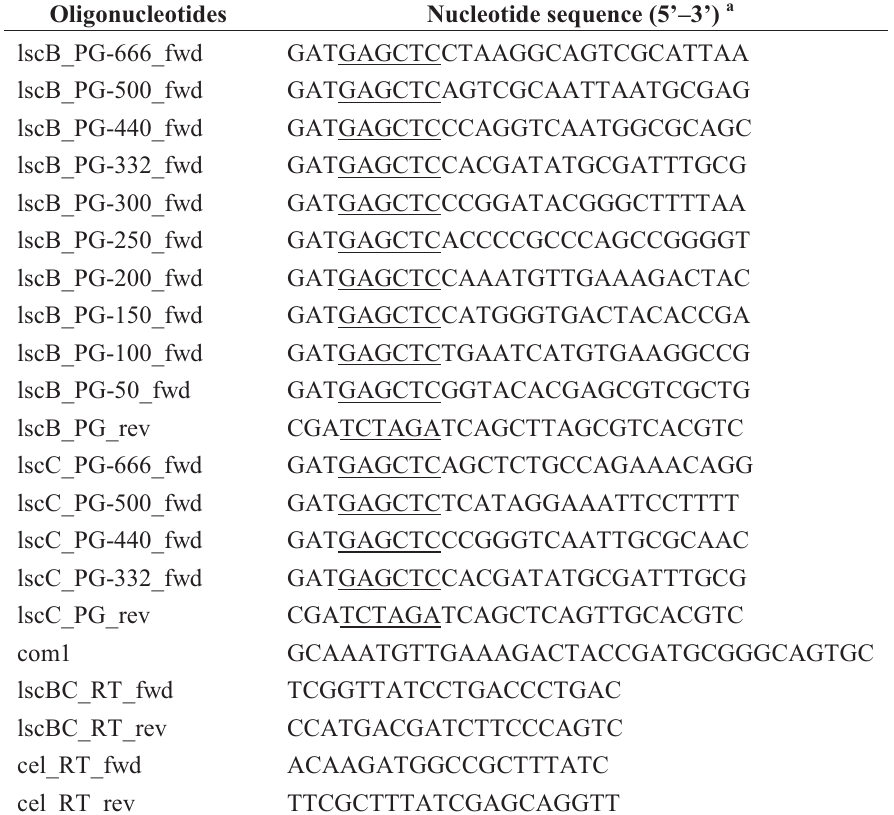
Table 4 . Oligonucleotide primers used in this study. Oligonucleotides Nucleotide sequence (5’–3’)